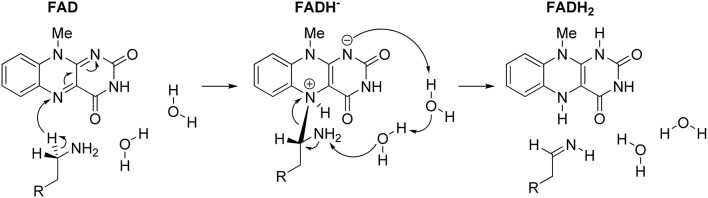
Complete two-step mechanism for MAO catalyzed amine degradation. The first step involves H− abstraction from the substrate to form the flavin–substrate adduct, which then decomposes to the final products, namely neutral imine and fully reduced flavin, FADH2, a reaction promoted by amine deprotonation facilitated by two water molecules.